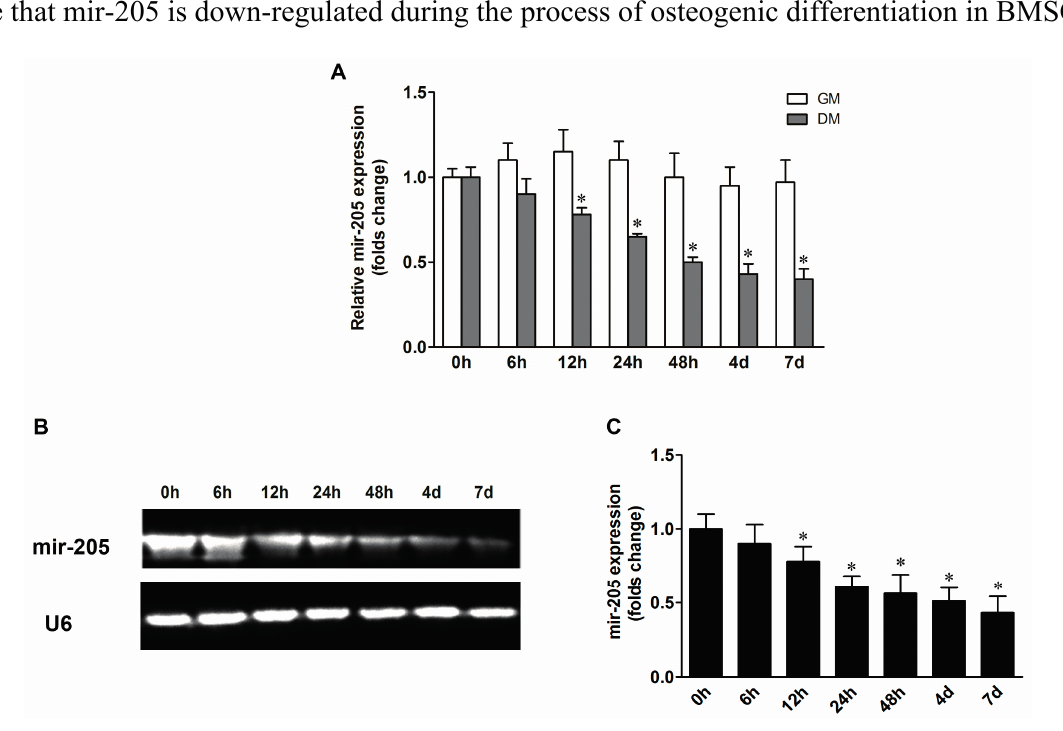
Figure 1. Mir-205 expression during the process of osteogenic differentiation in bone mesenchymal stem cells (BMSCs). BMSCs were treated with growth medium (GM) or differentiation medium (DM) for seven days to investigate the change in mir-205 levels. ( A ) Mir-205 expression was decreased along a temporal axis in BMSCs; ( B , C ) Northern blot bands data show that mir-205 was down-regulated in a time-dependent manner during osteogenic differentiation, and small nuclear RNA (U6) was used as control. Data are depicted as mean ± SD, * p < 0.05 vs. 0